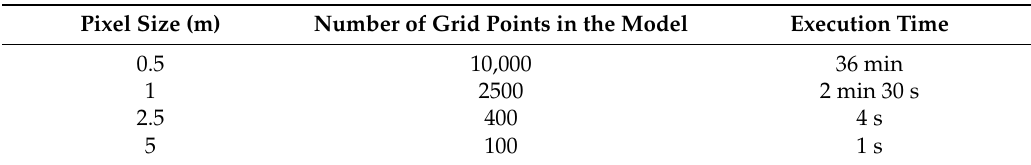
Table 4. Times of the script